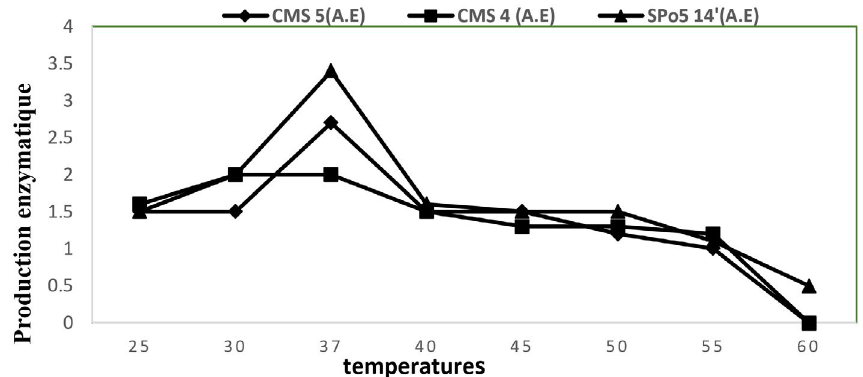
Fig. 3. Enzyme production in CMS5 ( Bacillus subtilis ), CMS4 ( Bacillus sp.) and SPo5 14' ( Bacillus velenzensis ) as a function of